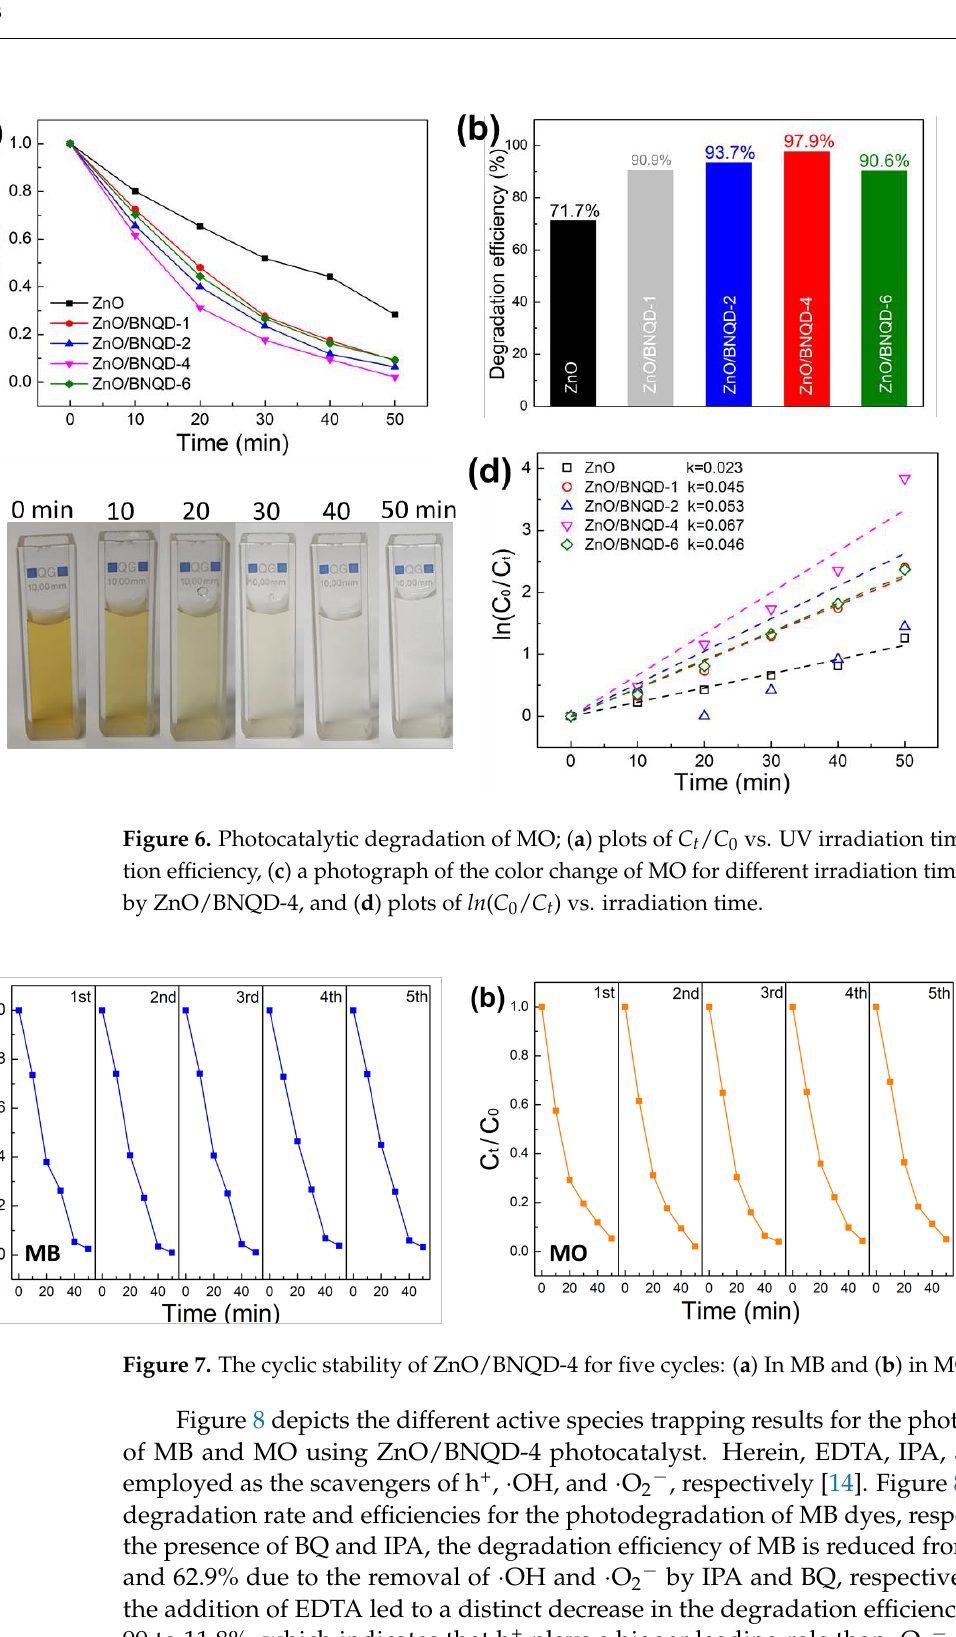
Figure 7. The cyclic stability of ZnO/BNQD-4 for five cycles: ( a ) In MB and ( b ) in MO.